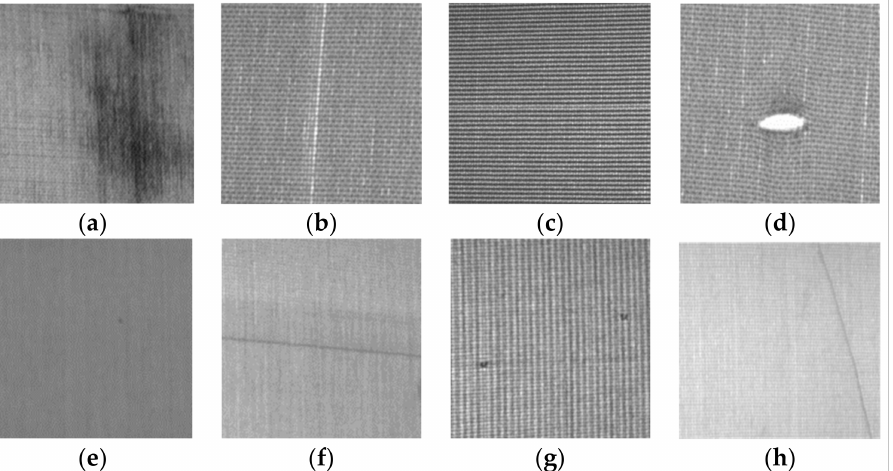
Figure 1. Eight mostly common occurring types of defects: ( a ) stain; ( b ) broken end; ( c ) broken weft; ( d ) hole; ( e ) nep; ( f ) double pick; ( g ) kinky weft; ( h )